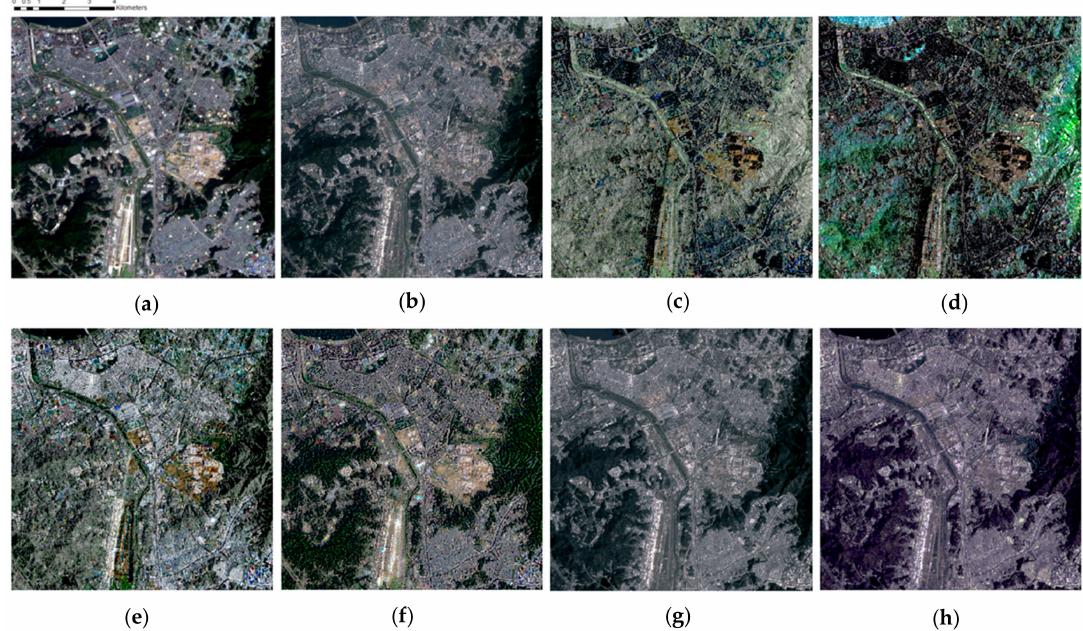
Figure 4. Comparison of fusion results for Site 1: ( a ) criterion Landsat-8 OLI image acquired on 19 September 2014, ( b ) our method, ( c ) modified intensity-hue-saturation (IHS), ( d ) principal component analysis (PCA), ( e ) Gram–Schmidt (GS), ( f ) Ehlers, ( g ) fused KOMPSAT-5 image through stochastic gradient boosting (SGB) regression, and ( h ) fused KOMPSAT-5 image through adaptive boosting (AdaBoost)